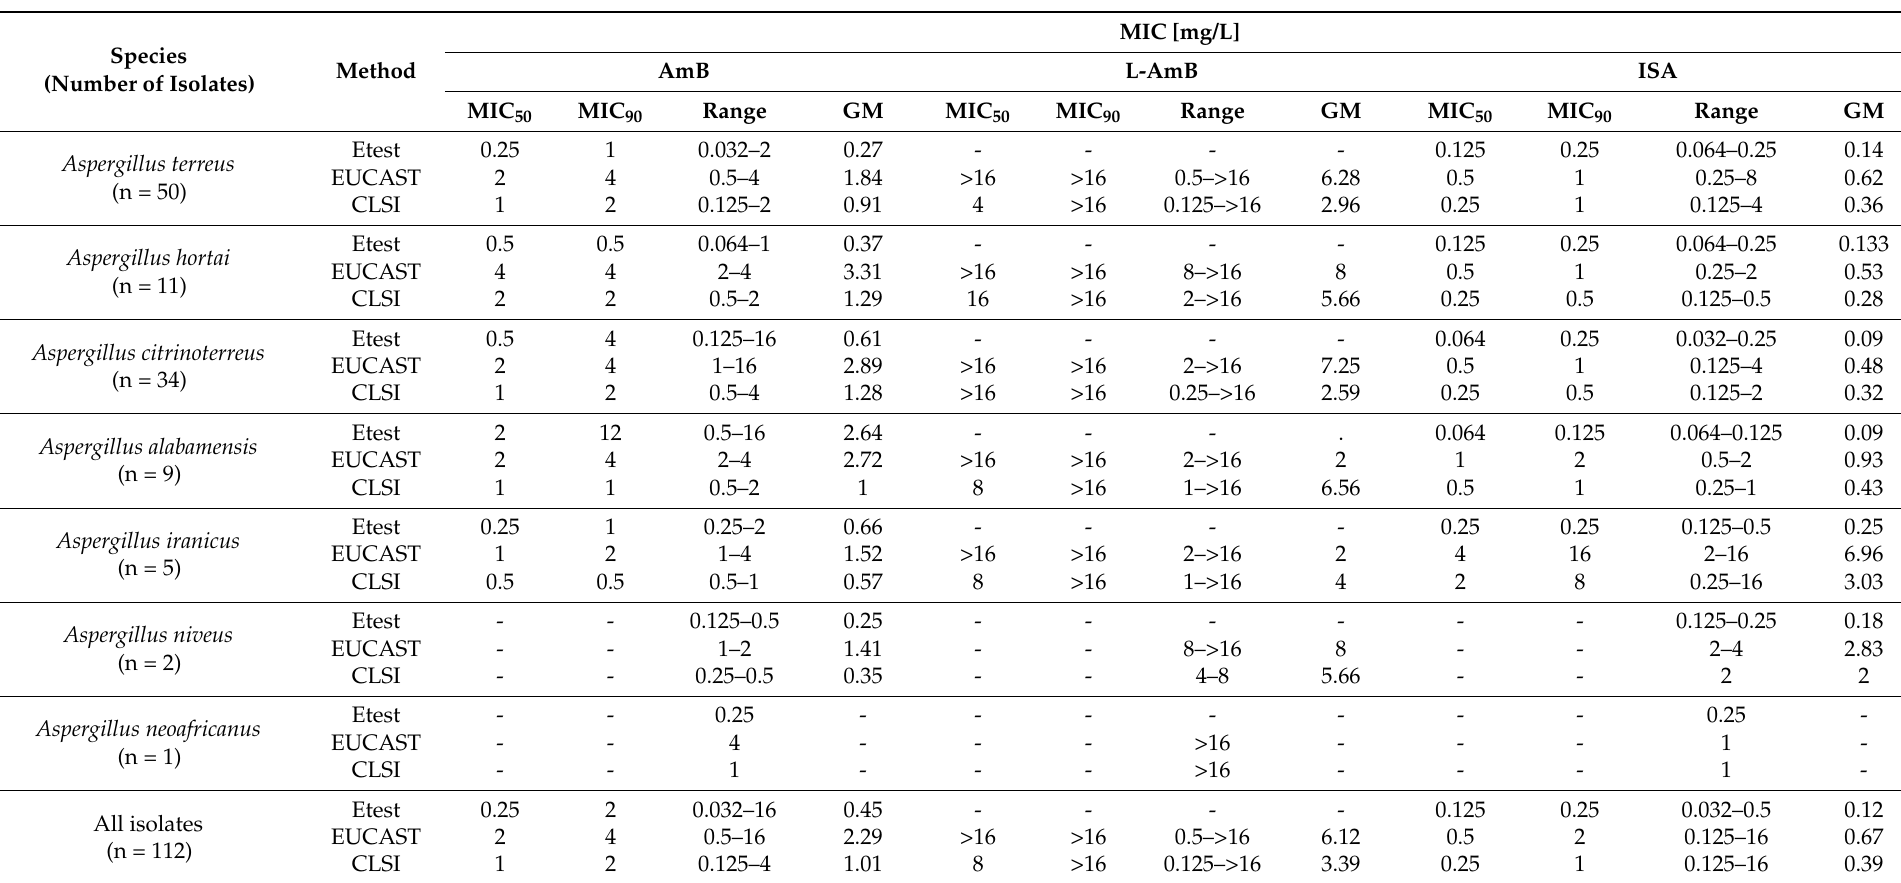
Table 1. Susceptibility profiles of amphotericin B (AmB), liposomal amphotericin B (L-AmB), and isavuconazole (ISA) against Aspergillus section Terrei,